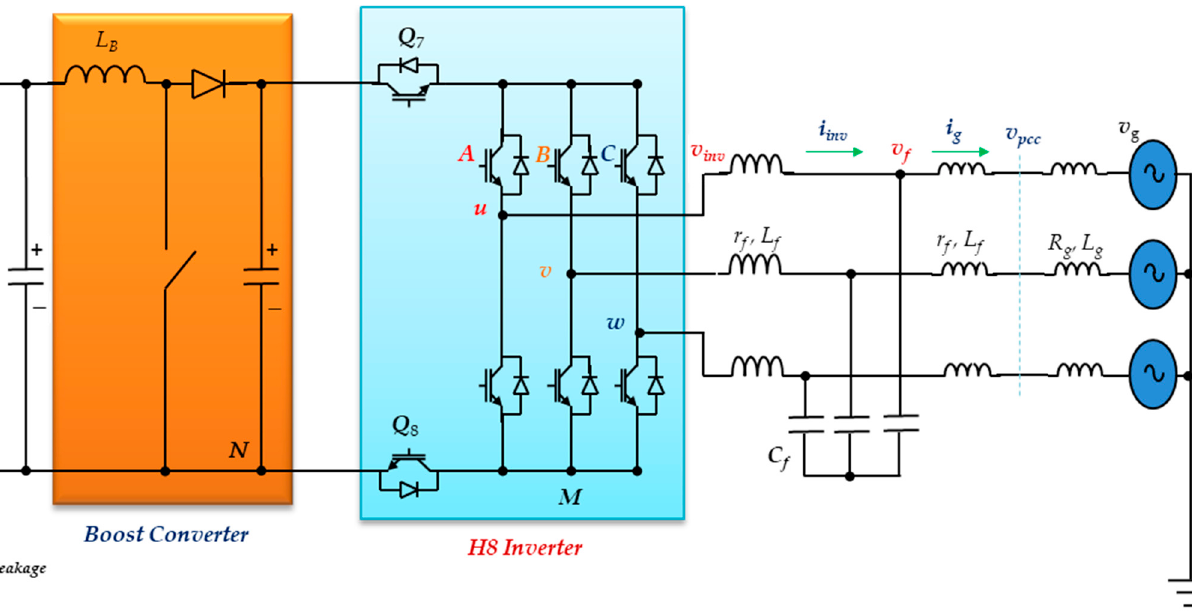
Figure 2. The configurations of the H8 inverter for ( a ) the active states and ( b , c ) the zero states.